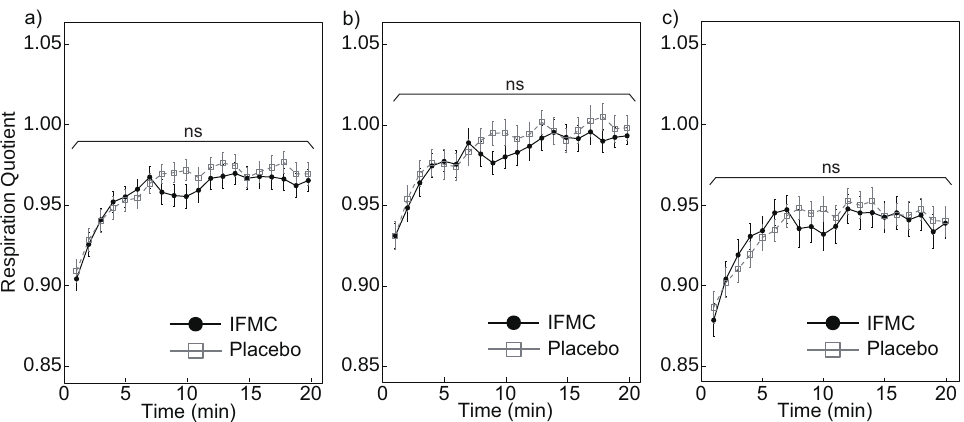
Figure 7. Differences in ( a ) all, ( b ) male, and ( c ) female respiratory quotient over 20 min between IFMC and placebo applications. The “ns” stands for “not significant ( p >